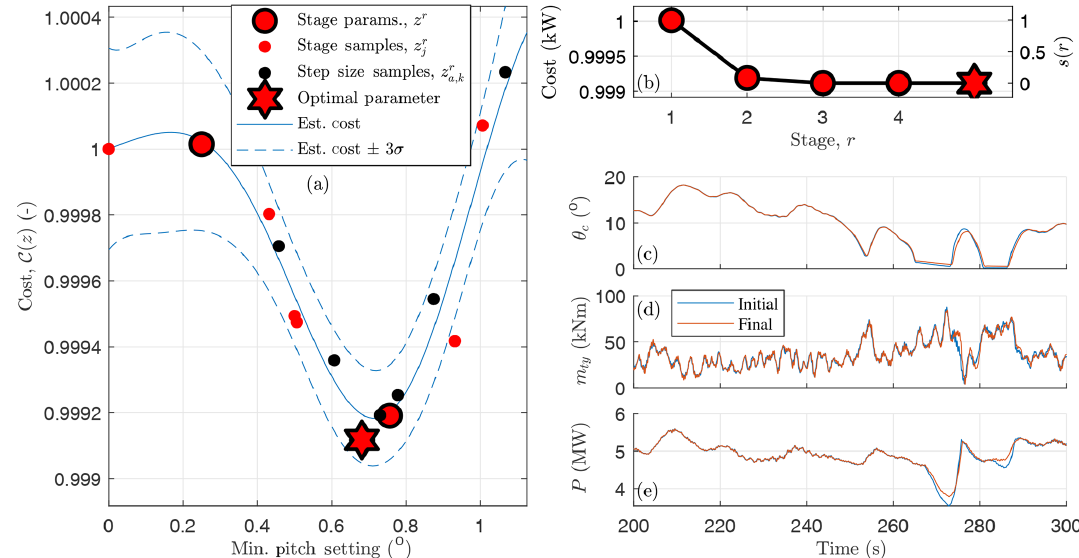
Figure 7. A zeroth-order optimization for the minimum pitch setting at 14ms − 1 for the NREL-5MW reference turbine. The cost C ( z ) in Eq. (35) is a function of the peak tower load m ty and mean of the generator power P in the simulation, where θ c is the collective pitch angle. The settling function s ( r ) is defined in Eq. (21) and the cost estimate is determined using all of the simulation results (15 unique pitch settings and simulations). Table 4. Parameters used to optimize the minimum pitch lookup table. Parameter Variable Value Cost model Load importance κ 0.01